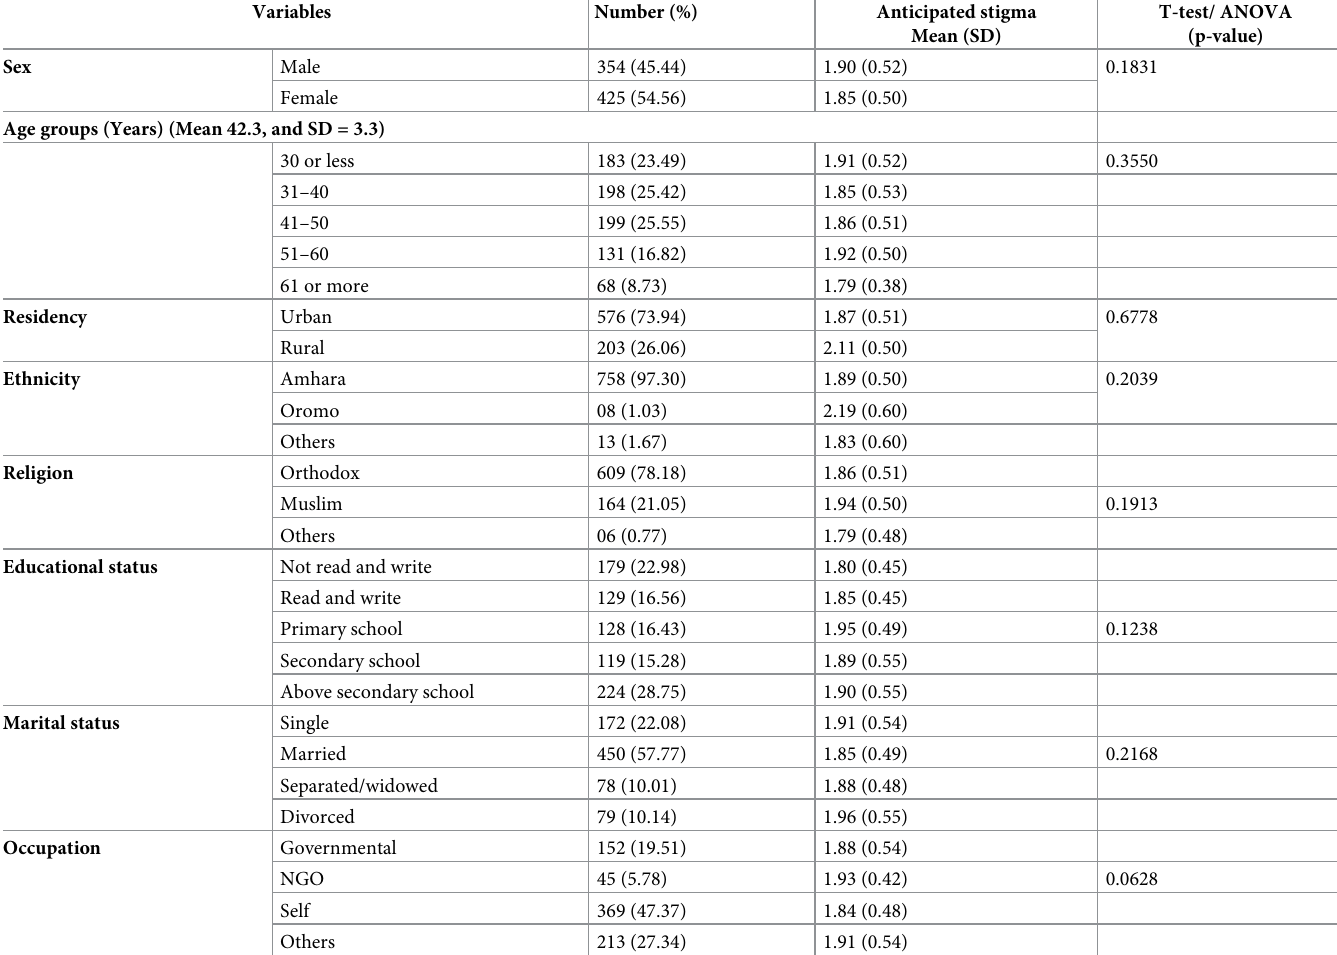
Table 1. Sociodemographic characteristics of patients with chronic illness in three Amhara region Referral hospitals, Northwest Ethiopia (n = 779).